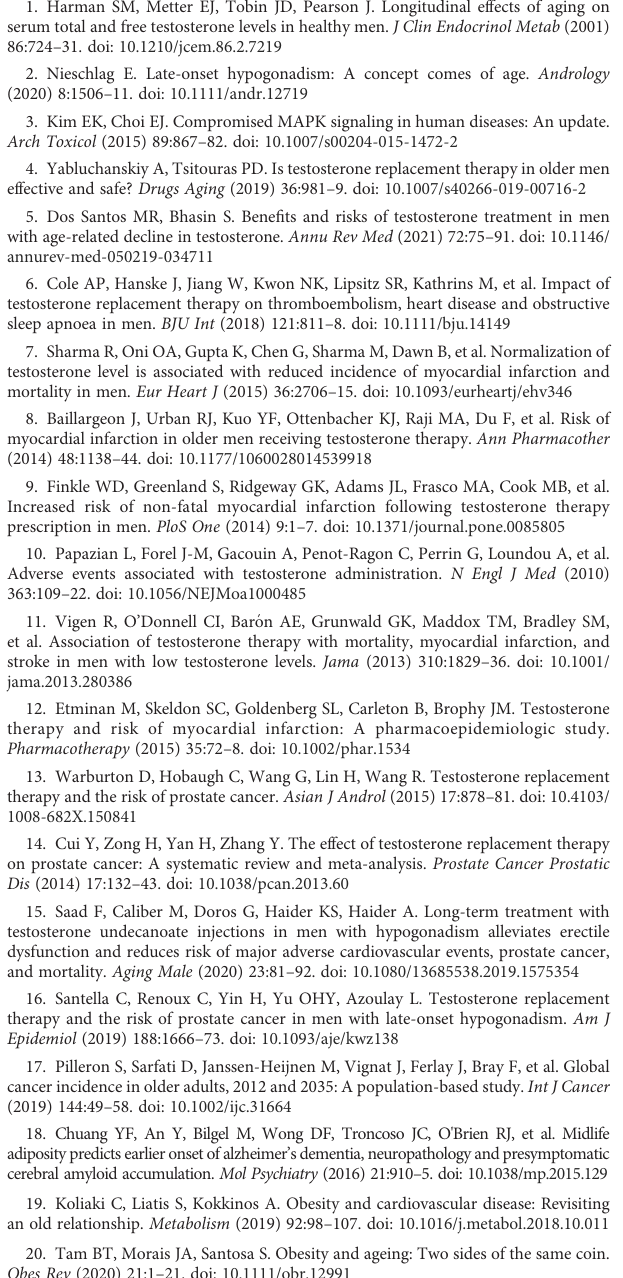
SUPPLEMENTARY FIGURE 1 The protein levels of JNK, p-JNK, ERK1/2, and p-ERK1/2 in testis of 6-and 18- month-old mice were assessed by immunoblot (A) . Quantitative analysis for protein levels of p-JNK and p-ERK1/2 (B, C) .